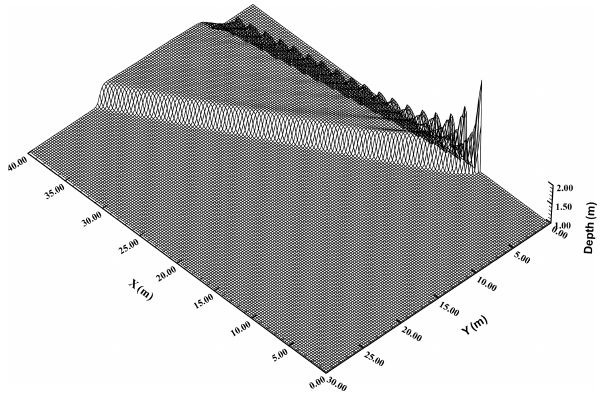
Figure 7. Steady state of water depth of oblique hydraulic